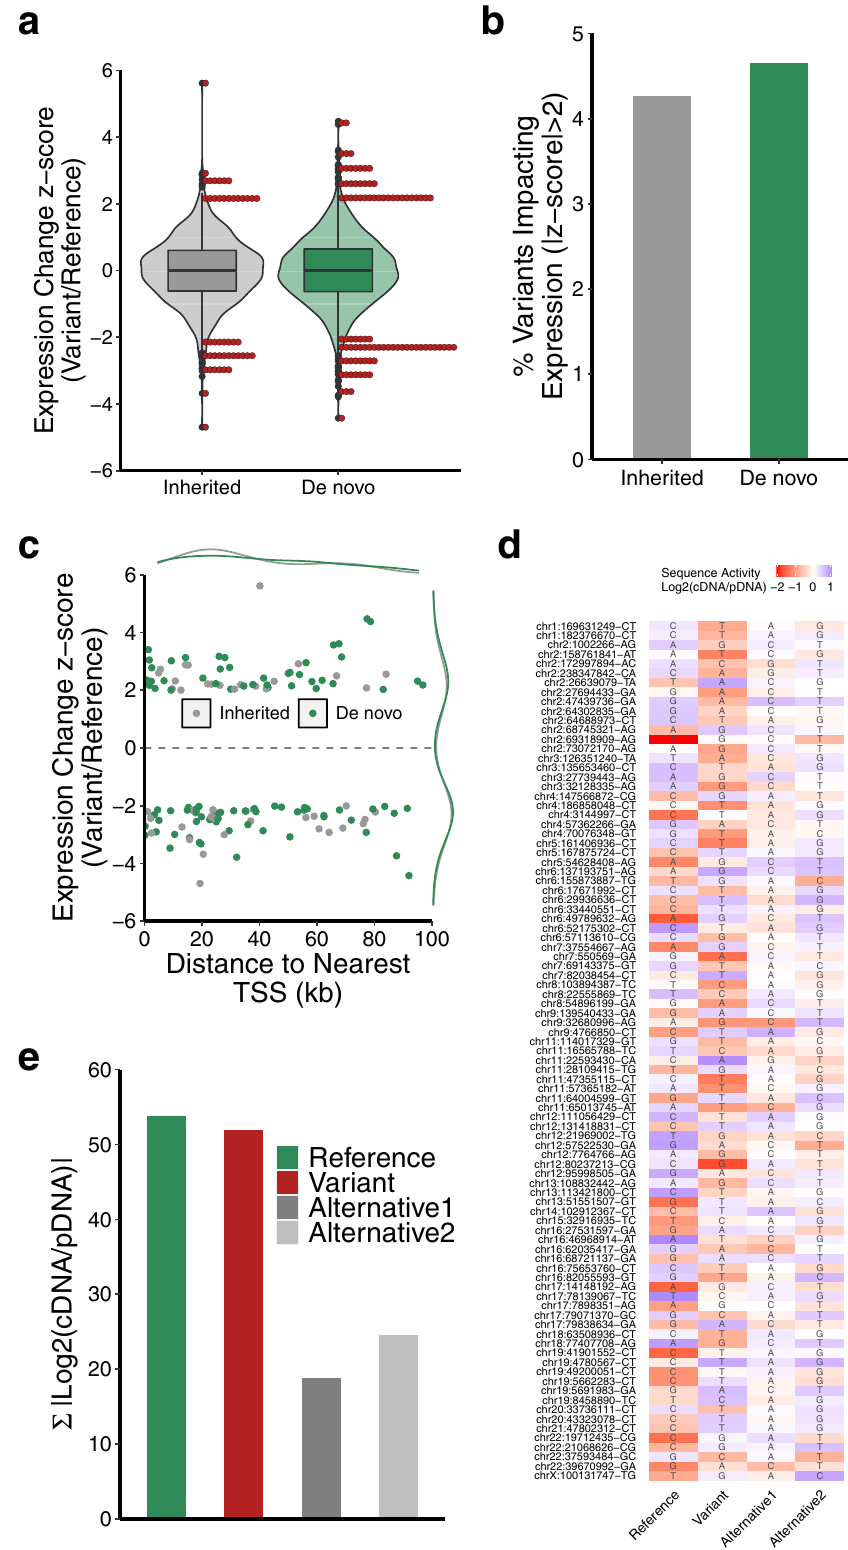
Figure 3. Rare genetic variants alter the regulatory capacity of genomic sequences. ( a ) Distribution of expression differences between reference and variant alleles profiled in MPRA (red points denote variants with an expression difference |z-score| > 2). ( b ) Fraction of profiled rare variants that alter regulatory capacity of genomic sequences. ( c ) Distance to nearest TSS for variants that alter the regulatory capacity of genomic sequences (|z-score| > 2). ( d ) Heatmap showing regulatory capacity of all possible alleles corresponding to de novo variants that display altered regulatory capacity (|z-score| > 2). ( e ) Aggregated regulatory capacity of genomic sequences shown in ( d ) by allele